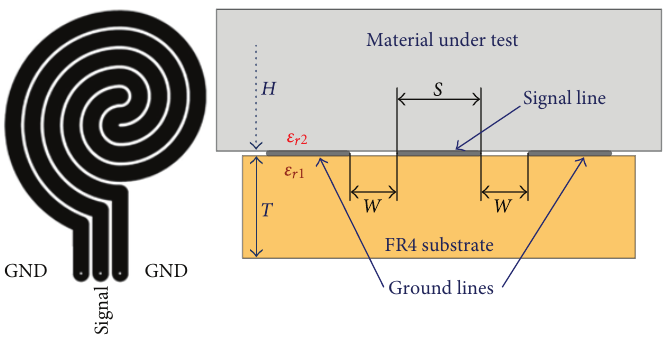
F 27: Surface capacitive sensor from [9].